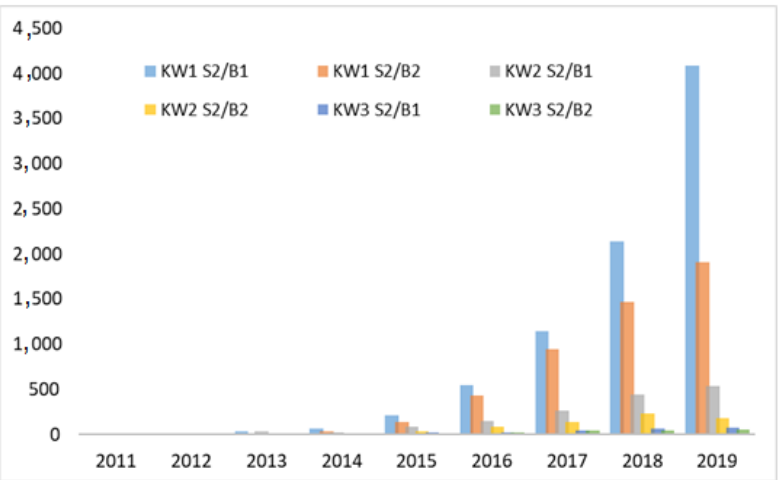
Figure 6. Number of scientific papers for particular keywords (KW) in the segment S2 “Industry 4.0”. Source: Own study based on the databases: Web of Science and Scopus.